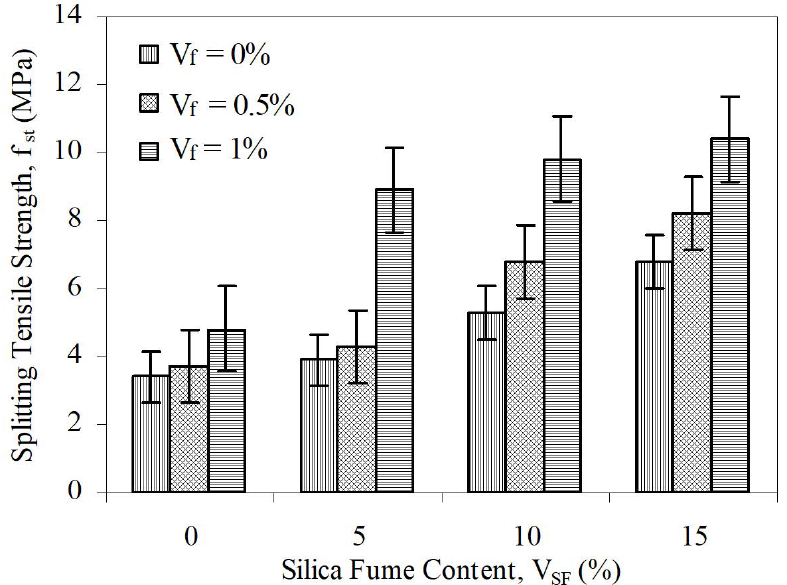
Figure 4. Load–deflection graphs of SFRCs for V f = 1% and aspect ratio of 65. Figure 6. The relation between f st and V SF at different V f for L/d = 65. Materials 2022 , 15 , x FOR PEER REVIEW